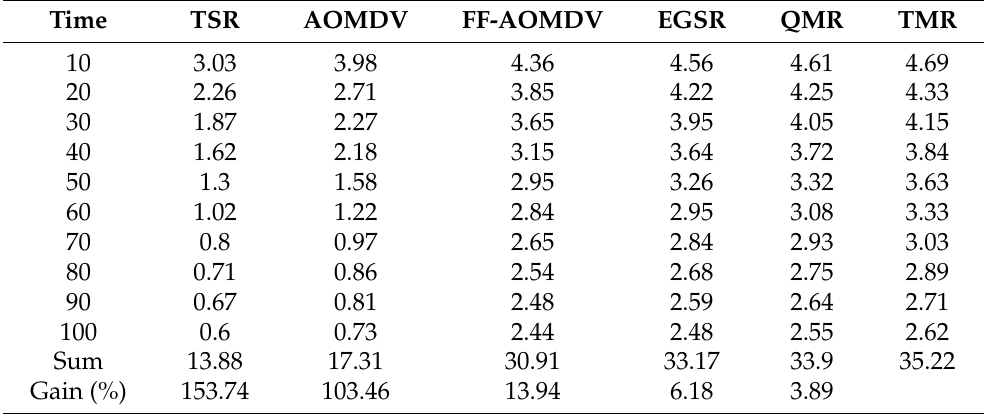
Figure 6. Comparison of AOMDV, FF-AOMDV, EGSR, QMR, and proposed protocol TMR and TSR for PLR with simulation time. Table 2. Simulation time vs. throughput of Figure